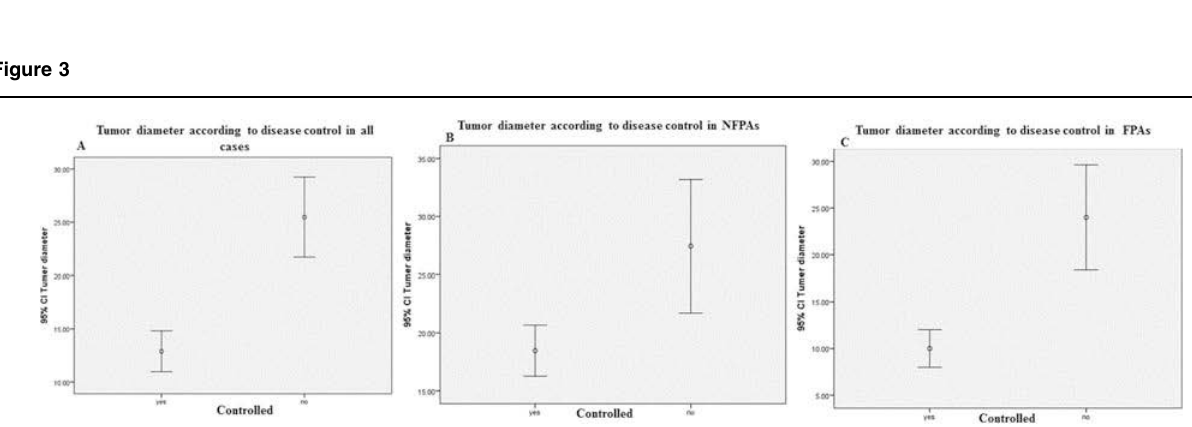
Association of tumour diameter with disease control for (a) all pituitary adenoma cases, (b) nonfunctioning adenomas and (c) functioning